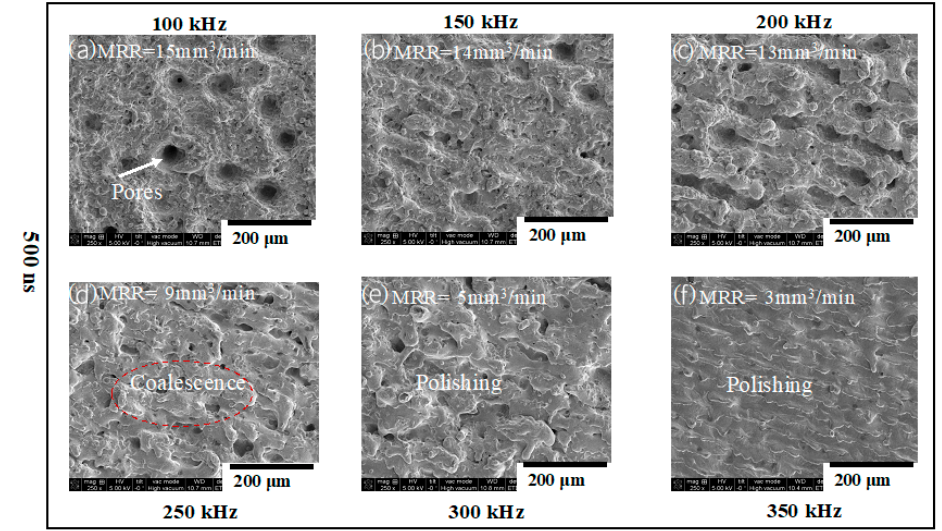
Figure 13. SEM micrographs of the surface morphology processed at di ff erent PRFs at ED A of 4.2 J / mm 2 at 500 ns.